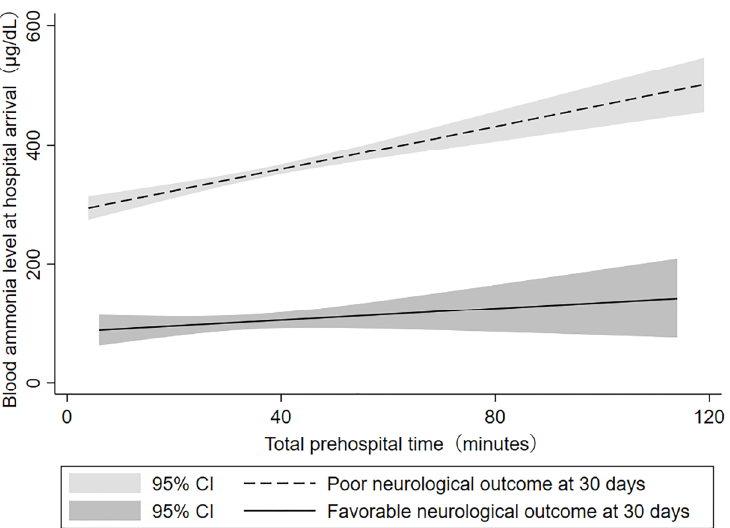
Figure 3. Relationship between blood ammonia level and total prehospital time. The blood ammonia level at hospital arrival increased with total prehospital time. The blood ammonia level in the favorable neurological outcomes group was lower than that in the poor neurological outcomes group. Abbreviations: confidence interval (CI).